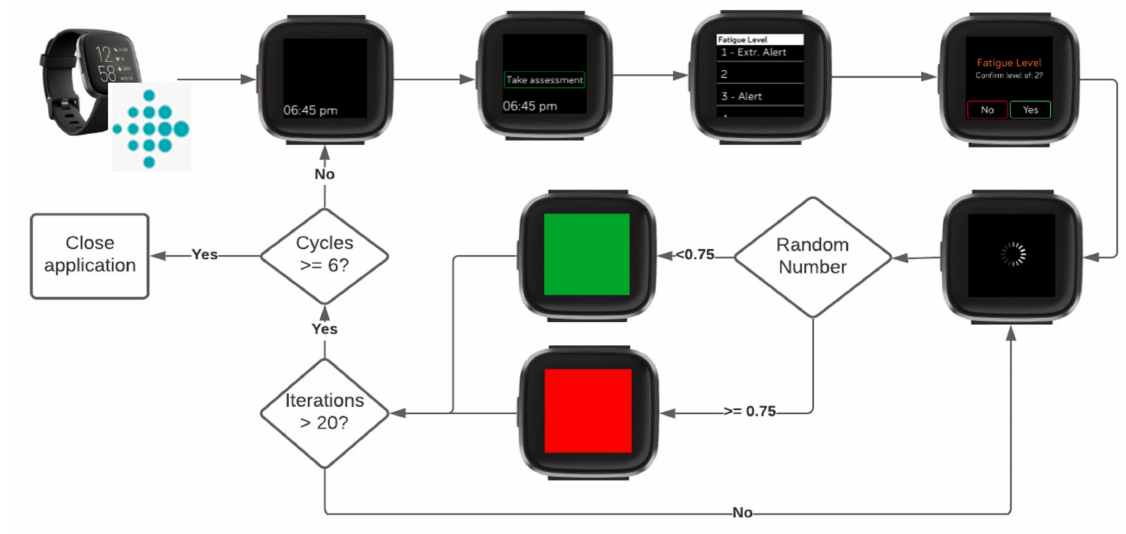
Figure 4. RTFM usability and logic